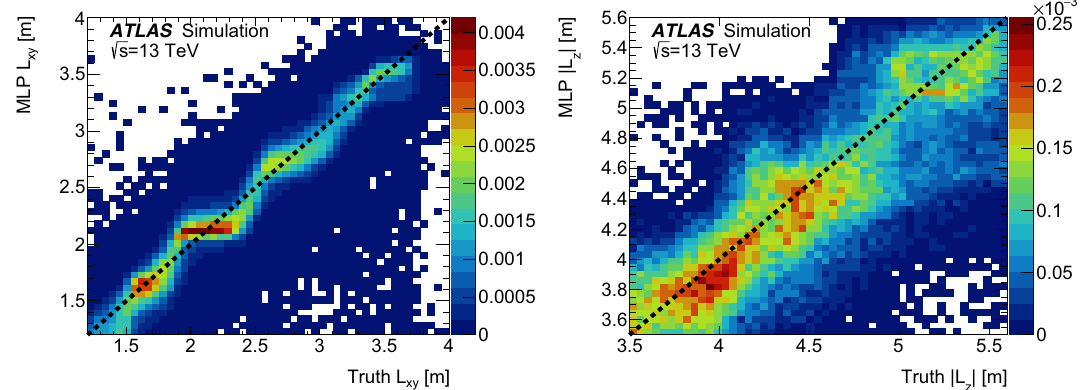
Fig. 3 Probability density of predicted MLP radial ( L xy , left) and longitudinal ( L z , right) LLP decay positions as a function of the truth LLP decay positions, for reconstructed jets matched to the LLP. Dotted lines show where the MLP value equals the truth